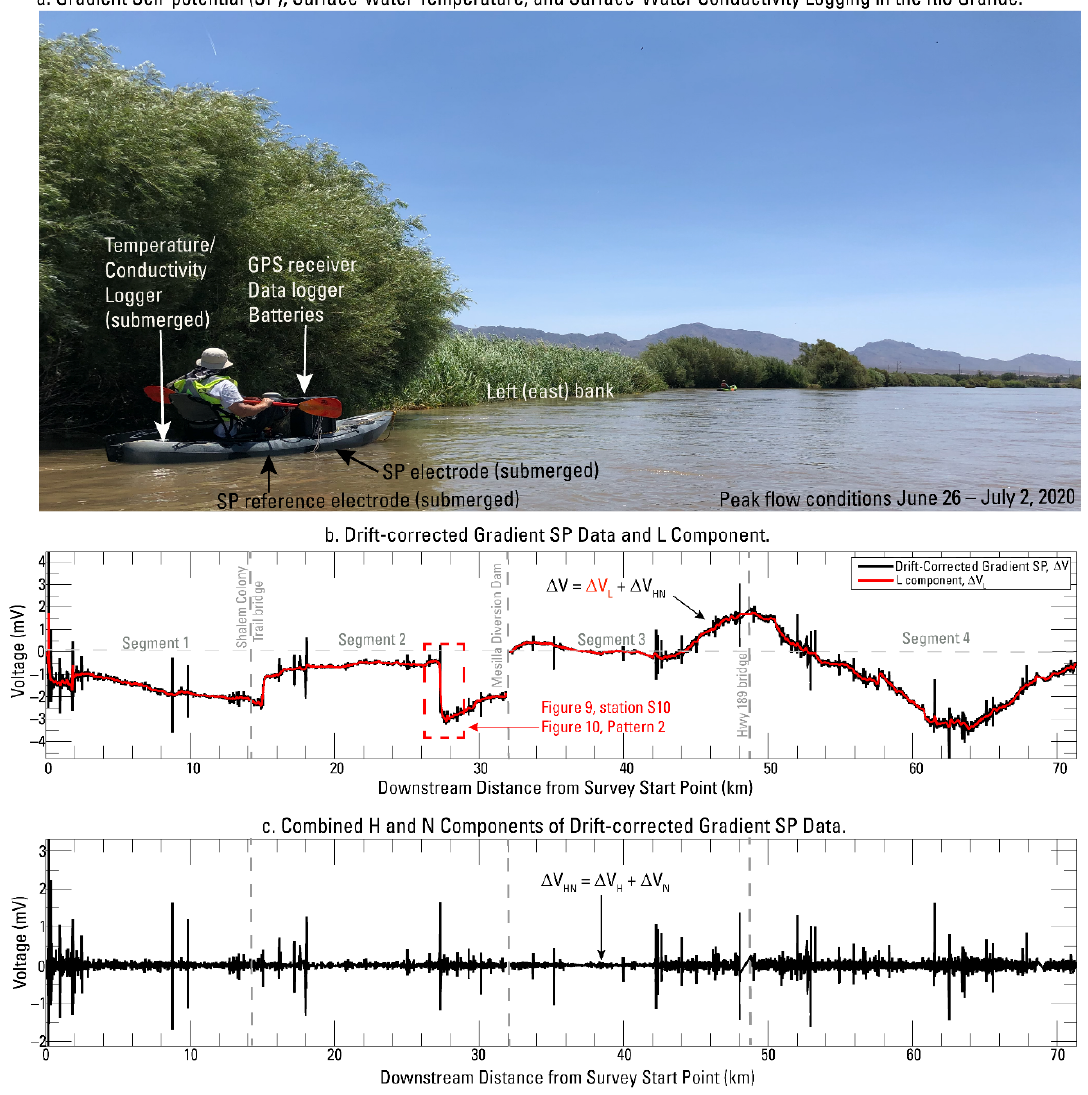
Figure 6. Photograph of data acquisition procedure, and drift-corrected gradient SP data measured in the Rio Grande across the Mesilla Valley with decomposed large- and small-scale spatial components. ( a ) Photograph of data acquisition procedure along the left (east) bank of the Rio Grande (looking downstream to the southeast). ( b ) Drift-corrected gradient SP data (black) and low-frequency (L) component (red) of the data determined by convolution with a Gaussian filter. ( c ) Combination of high-frequency (H) and noise (N) components of the drift-corrected gradient SP data, determined by subtracting the L component from the drift-corrected gradient SP data. The starting and ending points of survey segments 1–4 are depicted in Figures